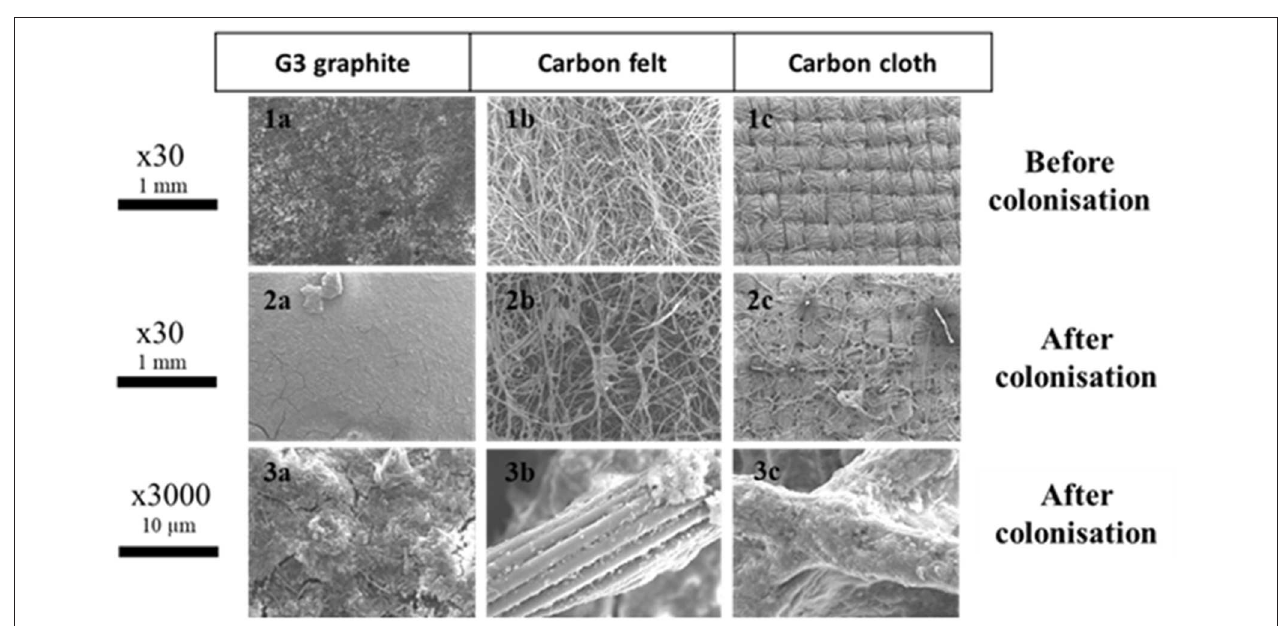
TABLE 5 | Average current density obtained in steady state on CF, CC, and G3 graphite. Steady state current density (A/m ² ) Run 1 Run 2 Given for each replicate and averaged on both replicates.